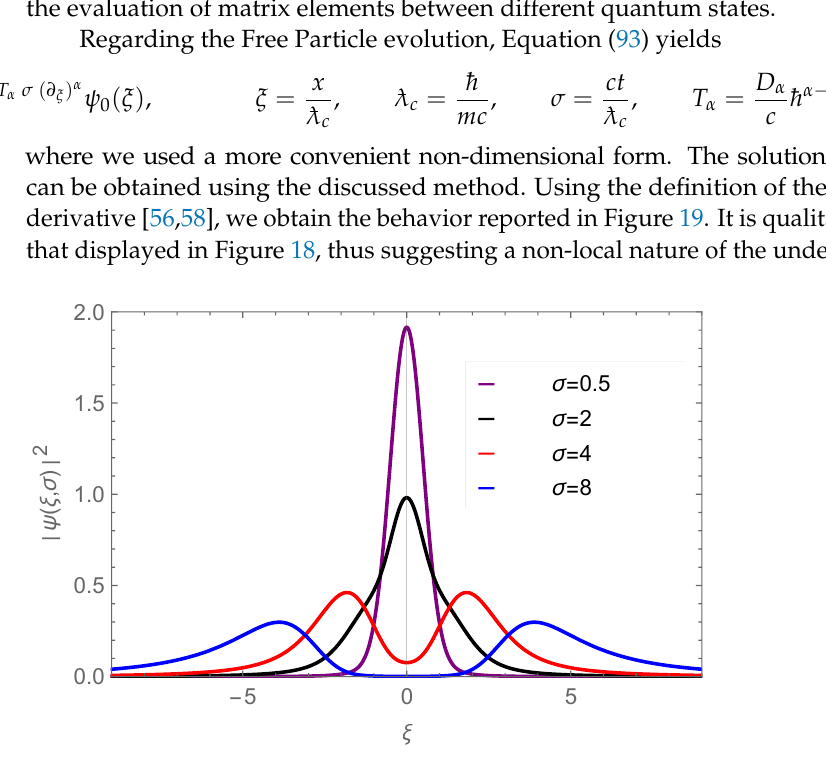
Figure 19. | ψ ( ξ , σ ) | 2 vs. ξ for different σ